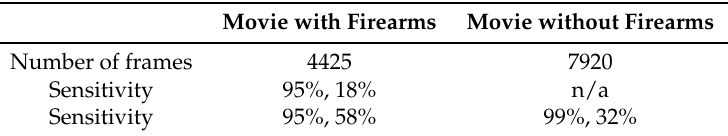
Table 5. Firearm detection: results for the base version of the